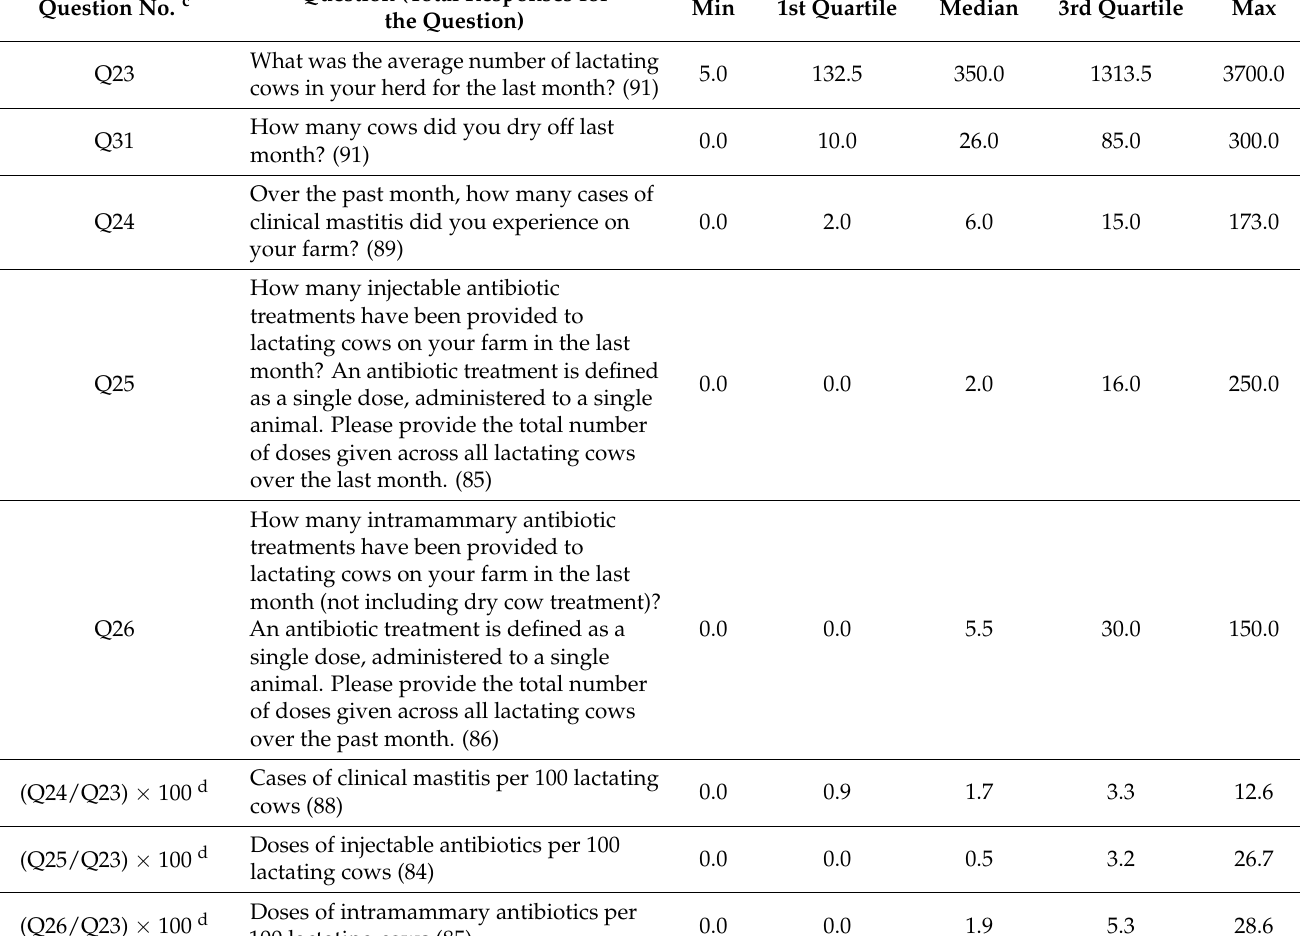
Table 2. Descriptive statistics for all responses to the numerical free choice survey questions about the participants’ farms and calculated frequencies of (i) clinical mastitis and (ii) injectable and (iii) intramammary antibiotic treatment doses per 100 lactating cows a,b